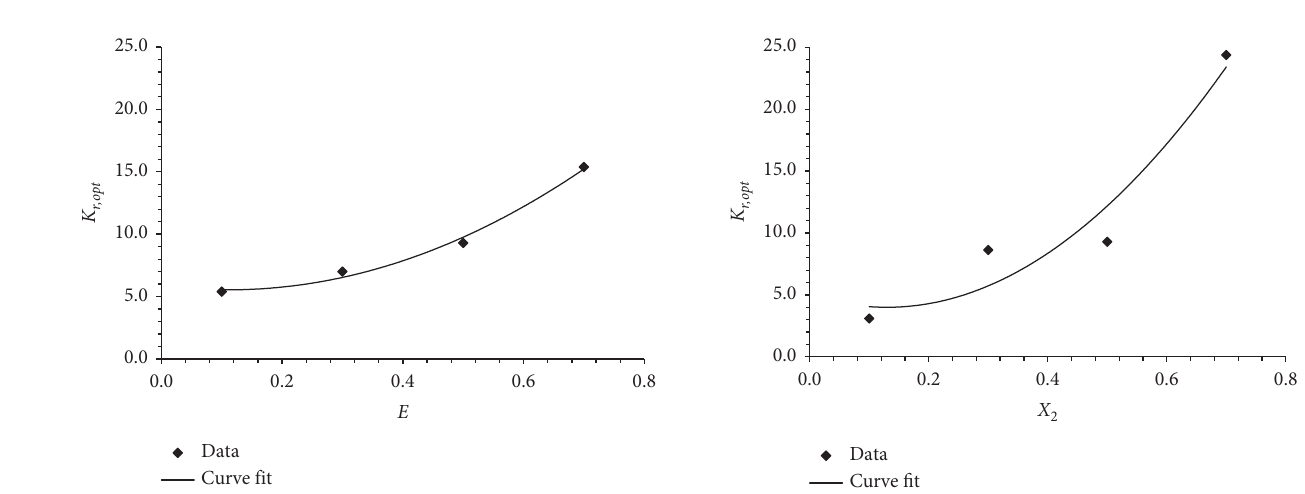
� 0.5, δ � 0.2, δ � 0.1. o i r ,opt at different values of